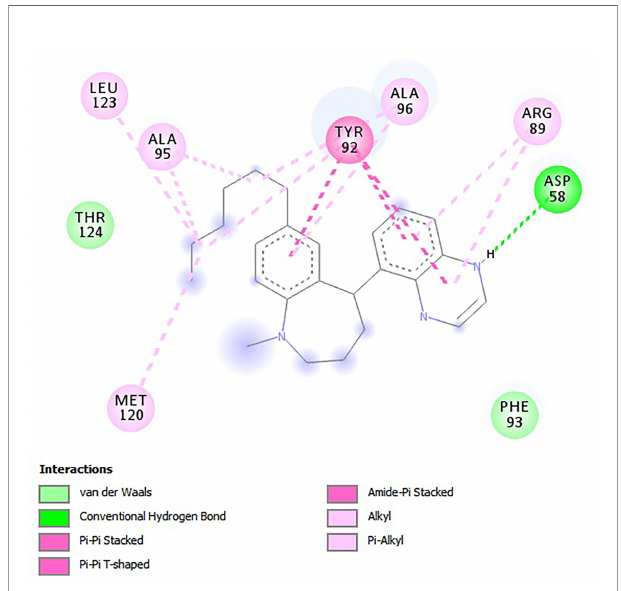
FIGURE 5 | 2D interaction pro fi le of the Ld SMT – A1 complex as visualized in Discovery